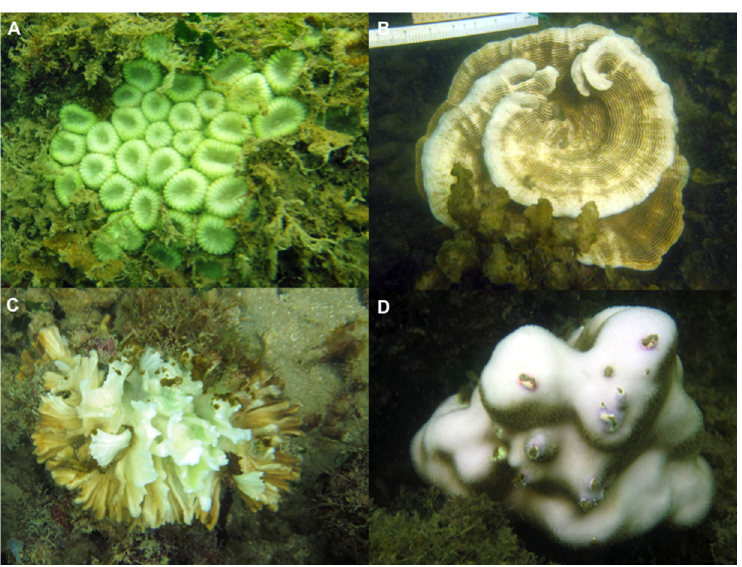
Fig 2. Coral genera that had the most number of bleached colonies during the 2013 minor bleaching episode in Singapore. Coral genera included (a) Dipsastraea , (b) Pachyseris , (c) Pectinia and (d) Porites .